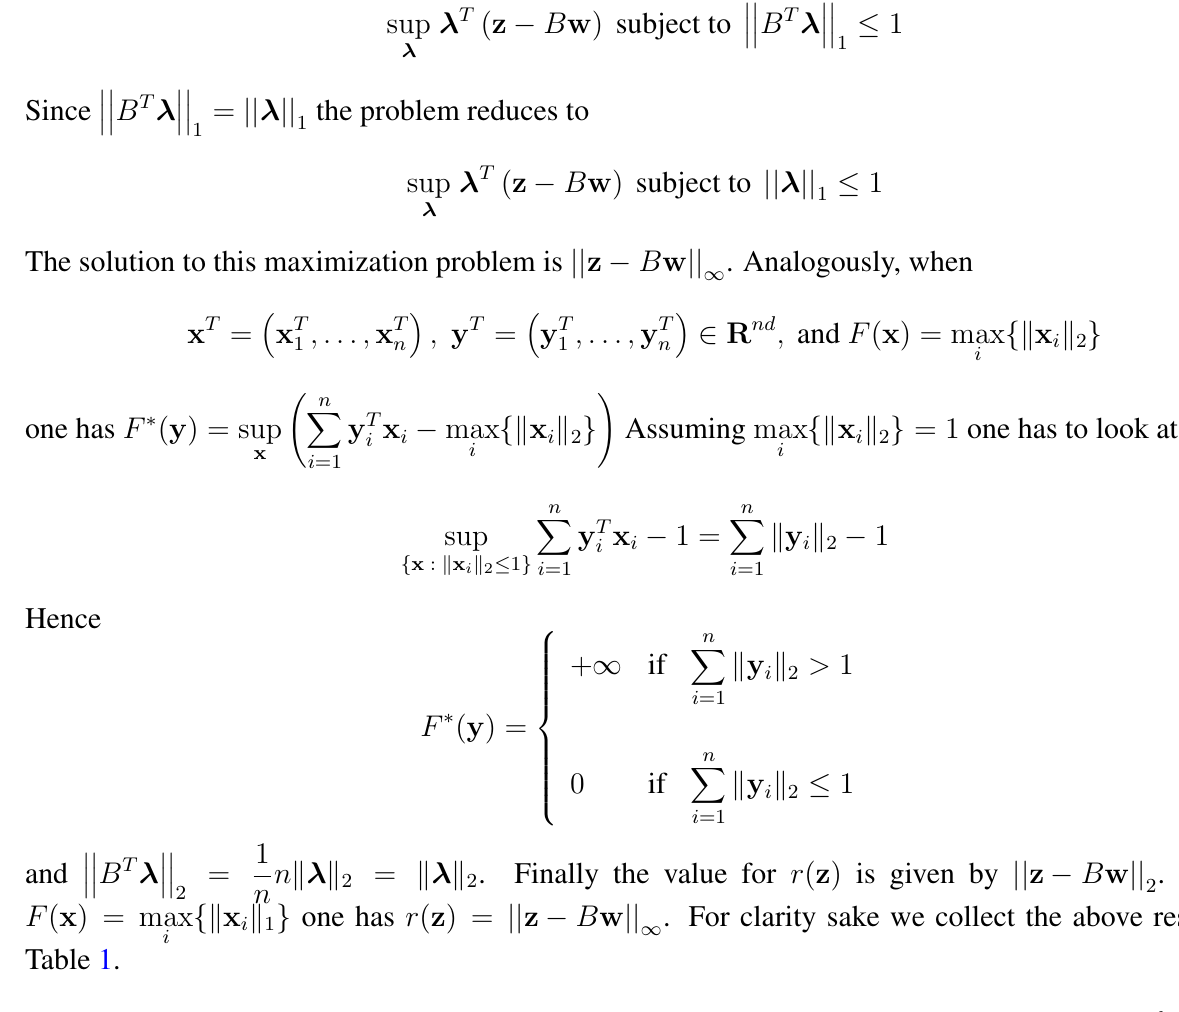
Table 1. norm–ball radius correspondence for three different norms and fixed w ∈ R nd .